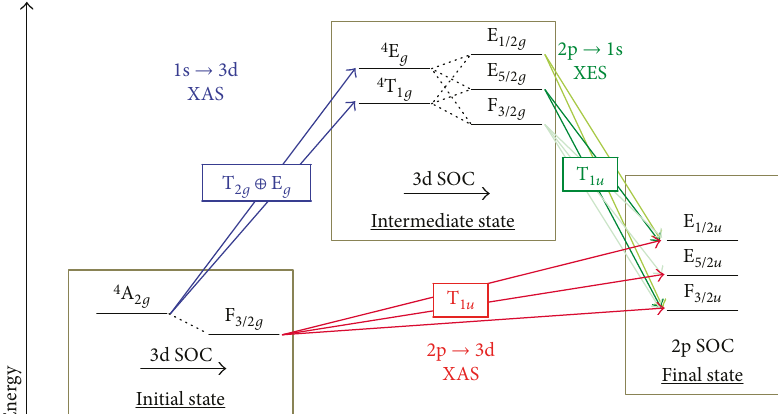
Figure 29: Multielectronic term scheme for Cr 3+ ( 3d 3 ) comparing the 1s2p RIXS and direct 2p XAS pathways. Where SOC is included, the spin multiplicity is omitted as its meaning is lost in that